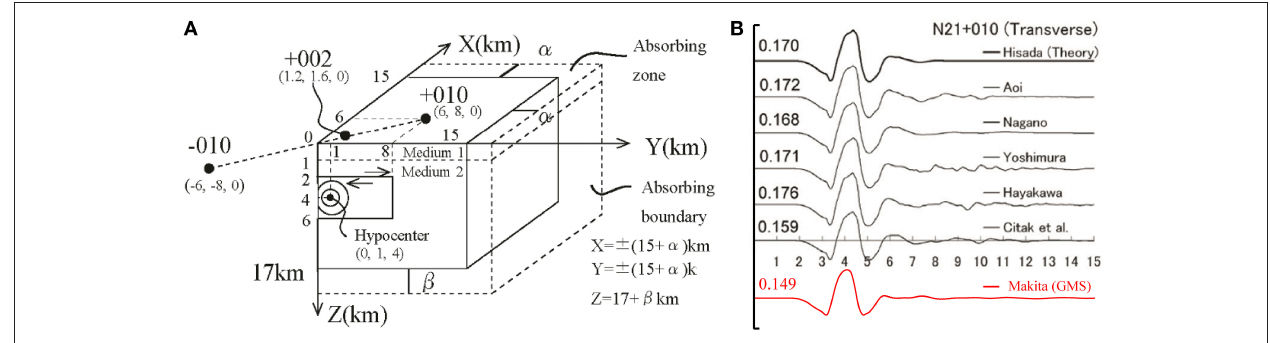
FIGURE A1 | Verification of the present computational method through comparison with benchmark test. (A) Fault plane and recording points (Yoshimura et al., 2011 ). (B) Comparison between the result due to the GMS and benchmark test (Partly from Yoshimura et al., 2011).